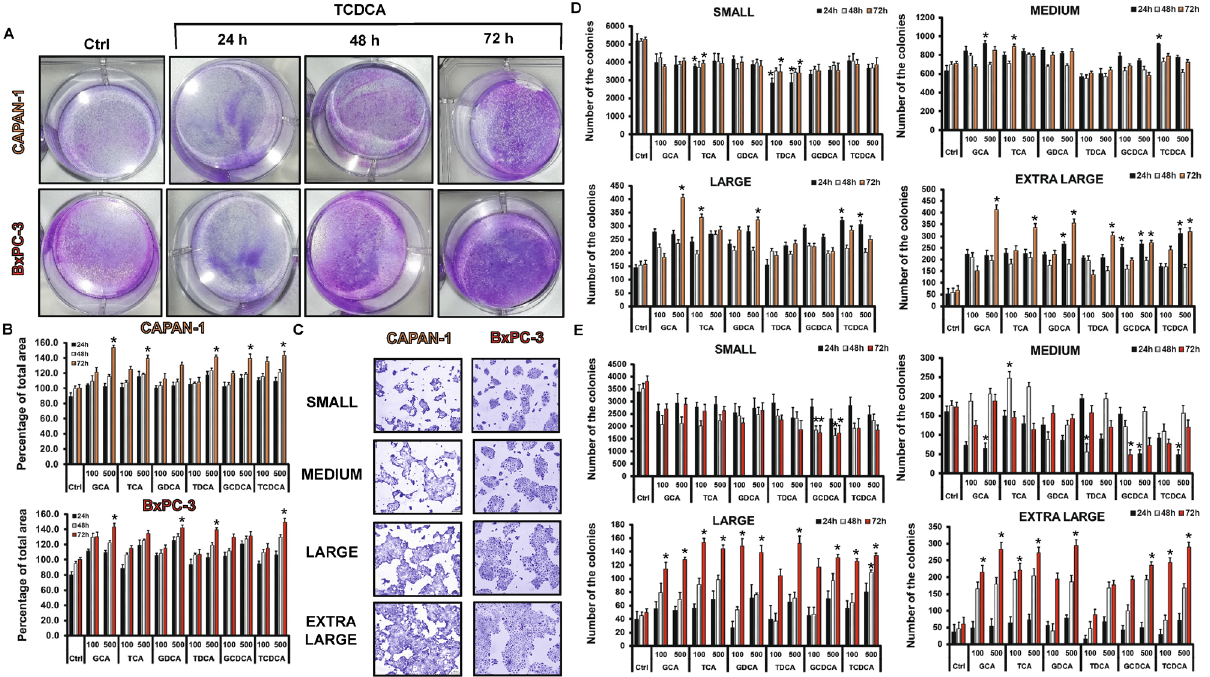
Figure 3. Effects of bile acid treatment on the colony forming of Capan-1 and BxPC-3 cells. Cells were exposed to different concentration of bile acids (BAs) and the colony forming ability of the cells was investigated by the clonogenic assay. ( A ) Representative pictures show the effect of taurochenodeoxycholic acid (TCDCA; 500 μM) at 24, 48 and 72 h. ( B ) Quantification of the colonies was performed using an Olympus IX83 microscope- based screening platform (Olympus cellSense Dimension software version 2.3, https ://www.olymp us-lifes cienc e.com/en/softw are/cells ens/). ( C–E ) For the classification and counting of the colonies an automatic Olympus Cellsense Dimension software was used. ( C ) Representative images showing colonies for each cell line. Summary diagrams for Capan-1 ( D ) and BxPC-3 ( E ) cells. Data represent mean ± SEM of three, independent